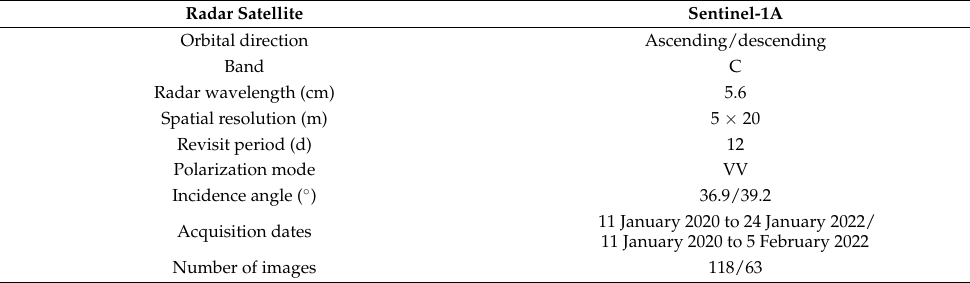
Table 1. Basic parameters of Sentinel-1radar satellite image used in the study.